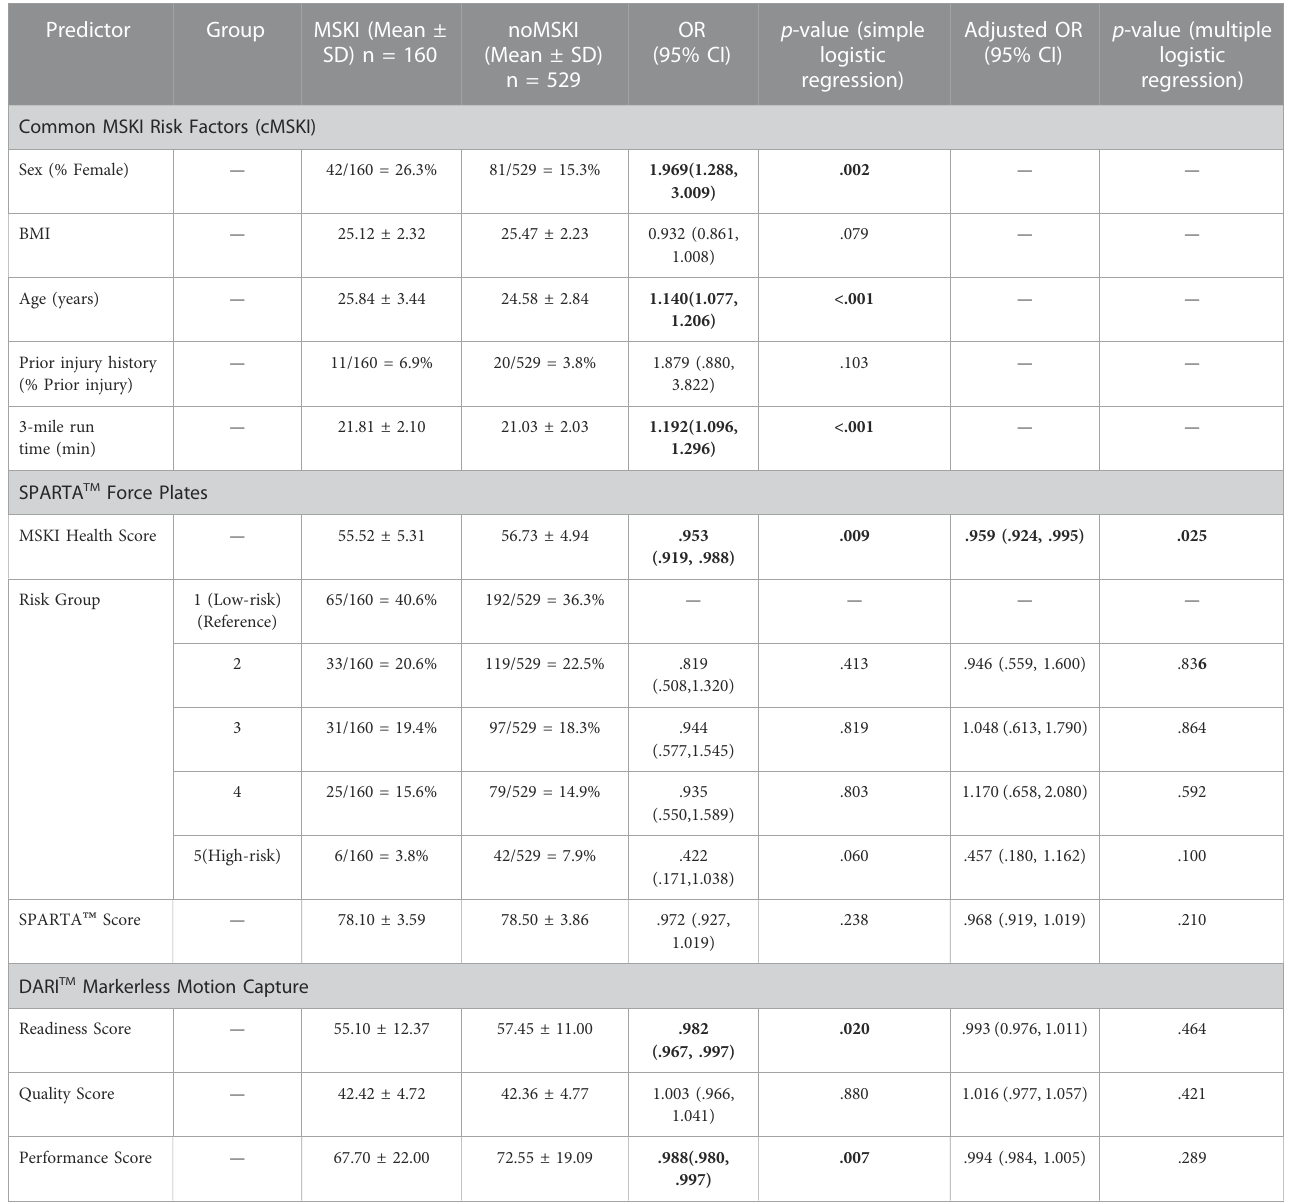
TABLE 3 Simple and multiple logistic regression. Predictor